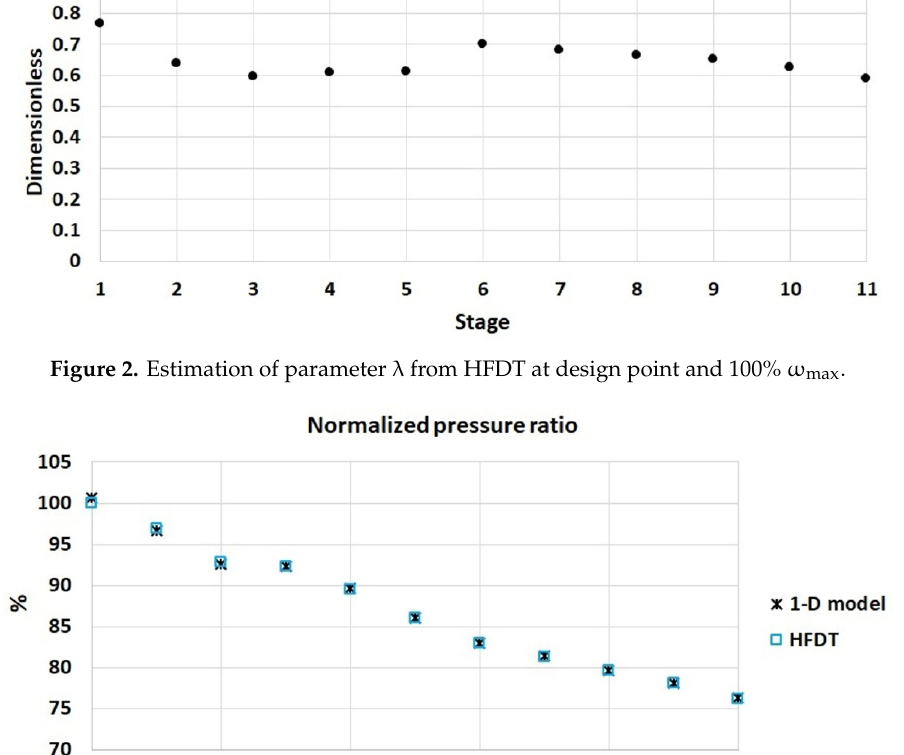
Figure 4. Comparison between stagewise temperature ratio from the 1-D model and HFDT at design point and 100% ω max .